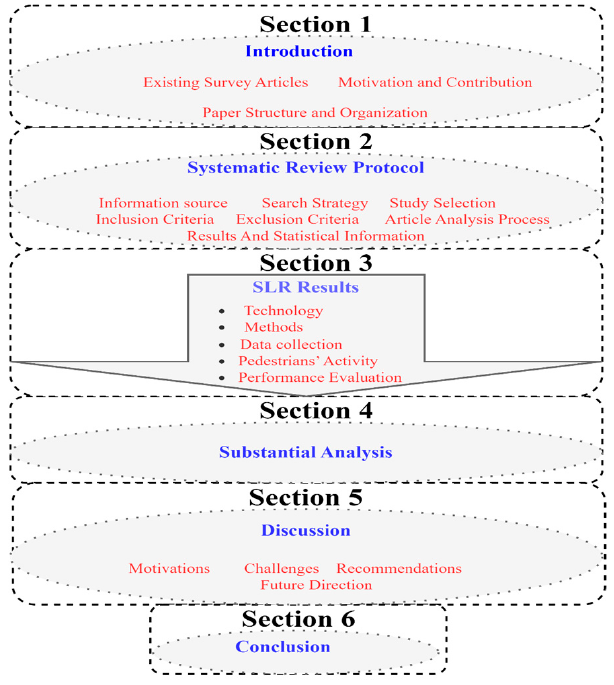
Figure 1. The structure of this article.